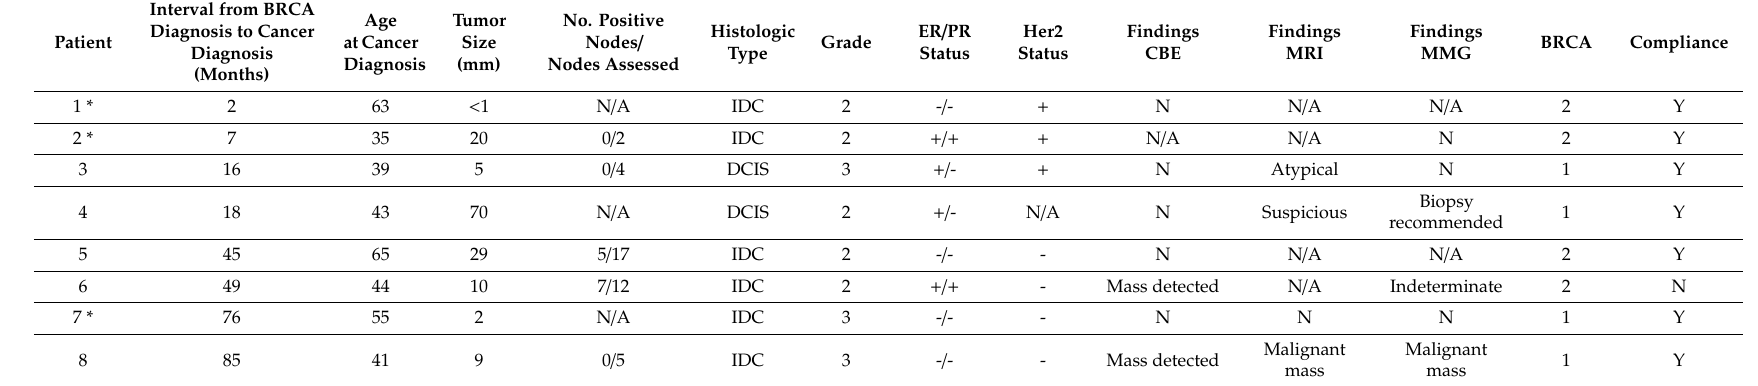
Table 5. Cancer Characteristics: PM /